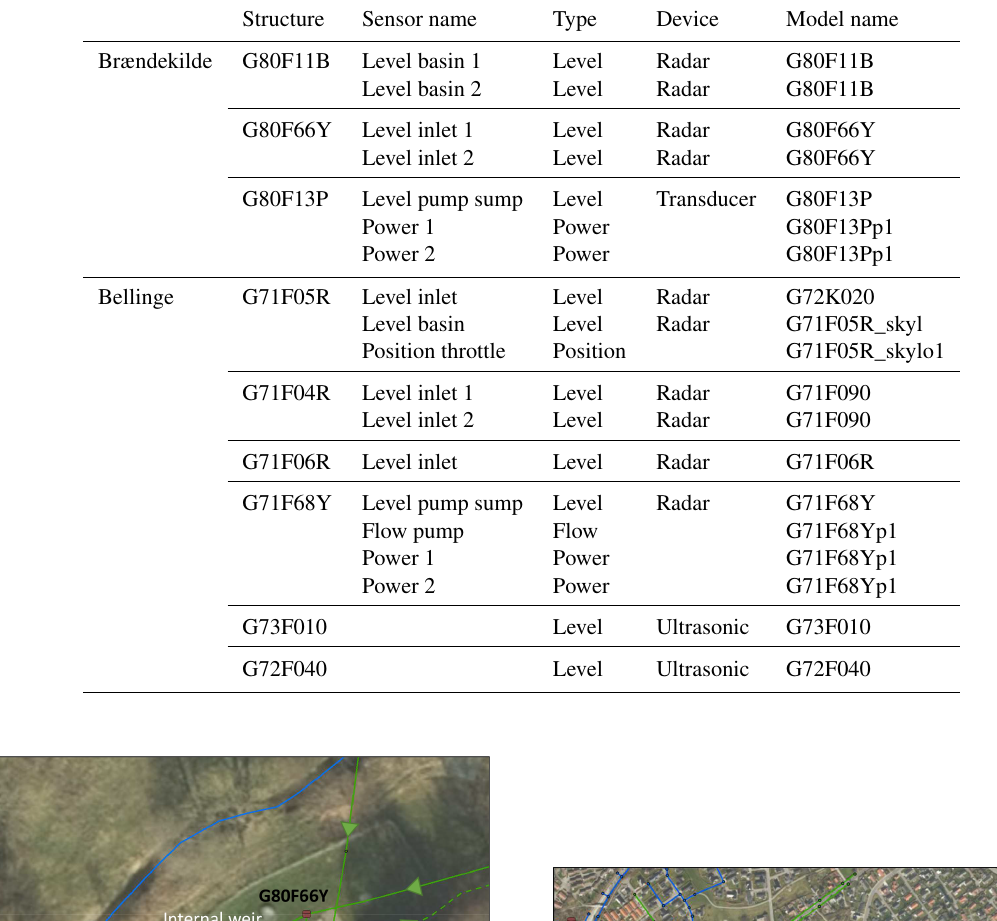
Table 1. Structures with sensors installed; see Figs. 1 and 3 for locations and Fig. 4 for details about the sensor installations. Corresponding model names are given. In all structures except G73F010 and G72F040 sensors are permanently installed.